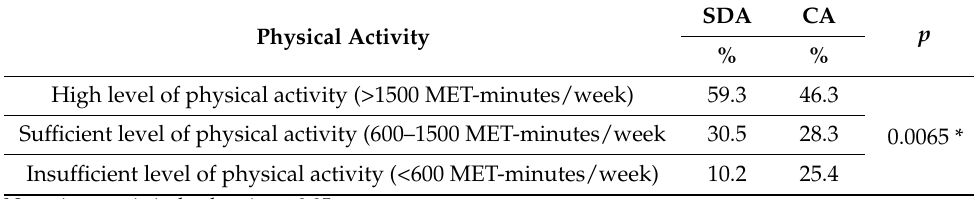
Table 6. Physical activity among SDA and CA. Physical Activity High level of physical activity (>1500 MET-minutes/week)